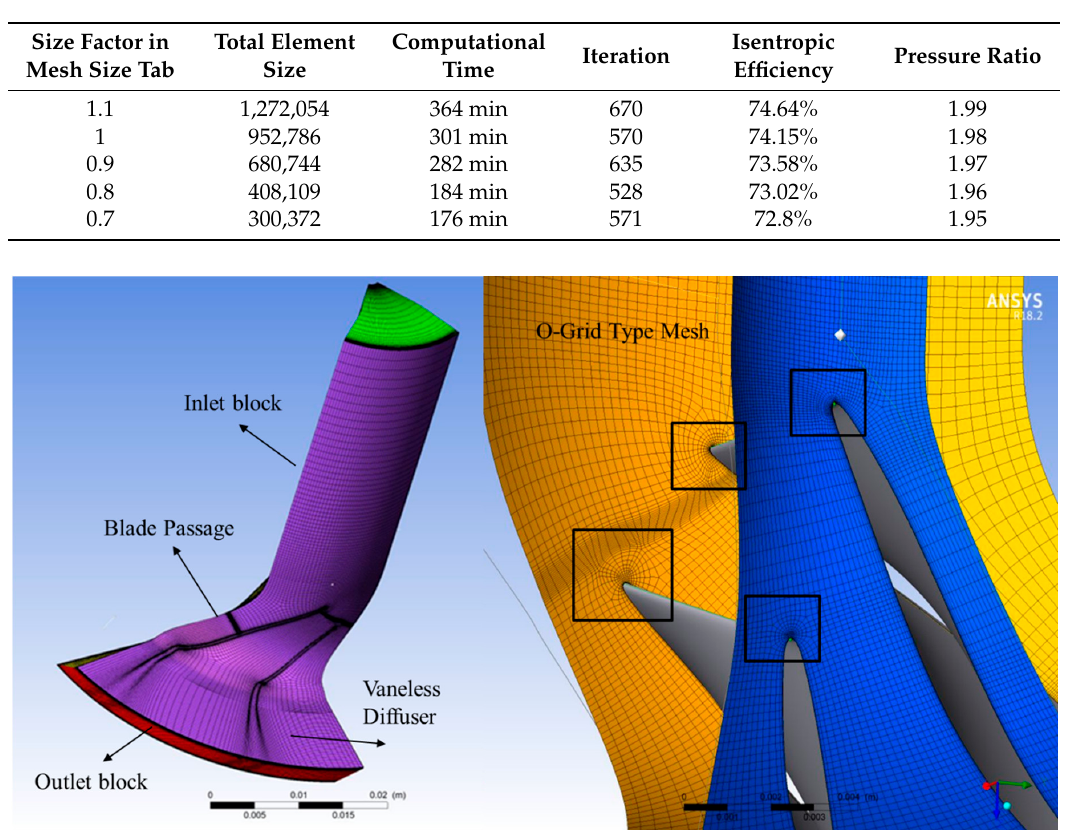
Figure 5. Discretization of the impeller inlet, outlet, and blade passage.